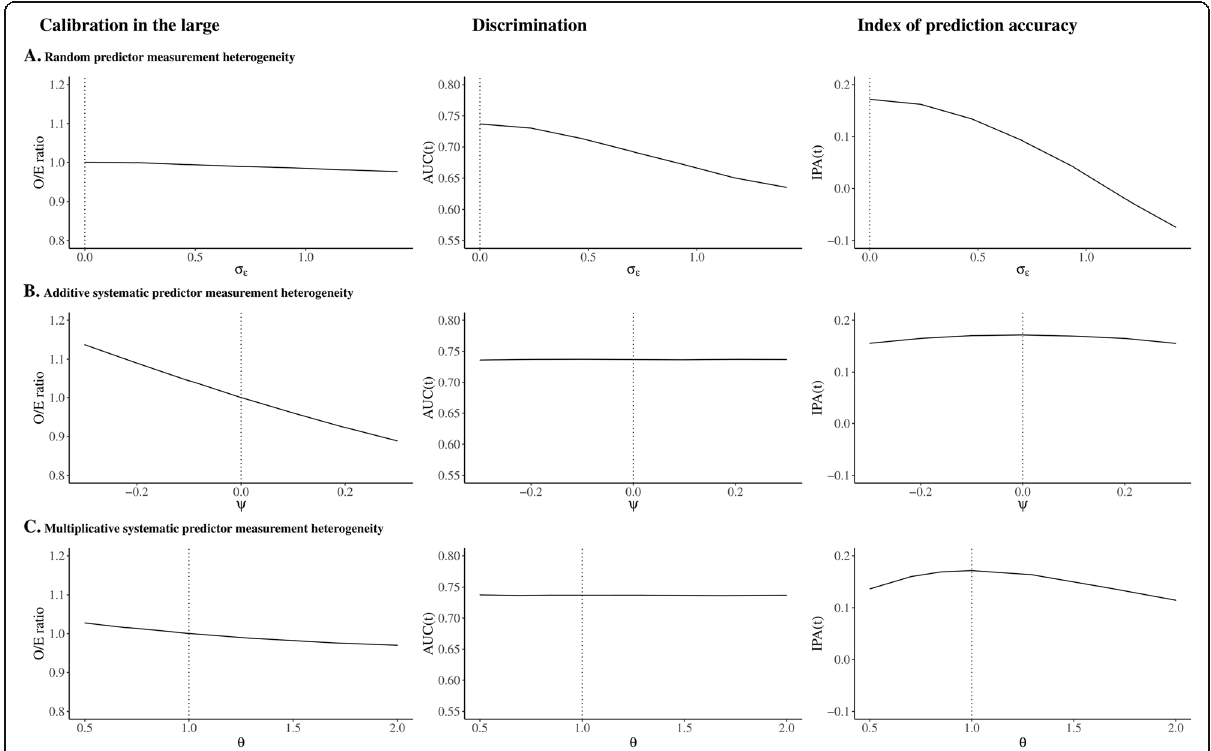
Fig. 2 Measures of predictive performance under predictor measurement heterogeneity between validation and implementation setting. Results shown for random predictor measurement only ( A ), additive systematic predictor measurement only ( B ), and multiplicative systematic predictor measurement heterogeneity only ( C ). The vertical dashed line indicates predictor measurement homogeneity between validation and implementation setting. The x -axes show measurement heterogeneity parameters describing the predictor measurement at implementation relative to the predictor measurement at validation, where σ ε denotes random deviations from the measurement at validation, ψ denotes an additive shift with respect to the measurement at validation, and θ denotes a systematic multiplicative association with the measurement at validation. Note that additional simulation scenarios were run to smooth the